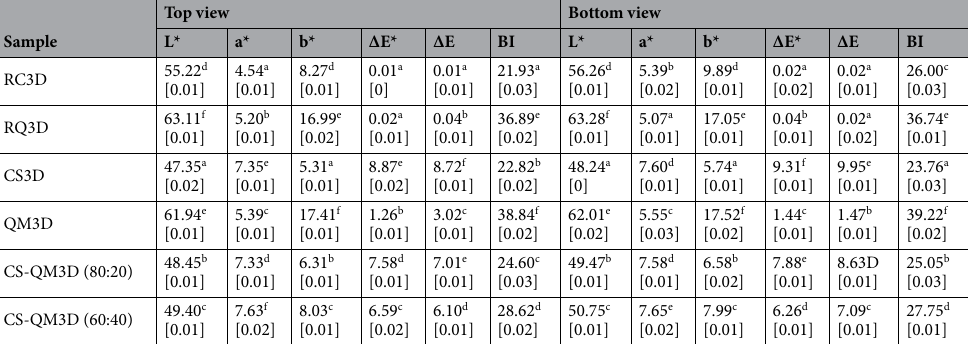
Table 3. Color profile of the raw, cowpea sourdough, quinoa malt whole and multigrain 3D-printed biscuits. Various superscripts presented per column indicate significant differences ( p ≤ 0.05). Values in square brackets are standard deviations of the respective means. L* lightness, a* redness, b* yellowness, ∆E* total color difference for CIELAB coordinates, ∆E total color difference for Hunter LAB coordinates, BI browning index, 3D three-dimensional, RC3D raw cowpea 3D-printed biscuit, RQ3D raw quinoa 3D-printed biscuit, CS3D cowpea sourdough 3D-printed biscuit, QM3D quinoa malt 3D-printed biscuit, CS-QM3D (80:20) 80% cowpea sourdough and 20% quinoa malt 3D-printed biscuit, CS-QM3D (60:40) 60% cowpea sourdough and 40% quinoa malt 3D-printed